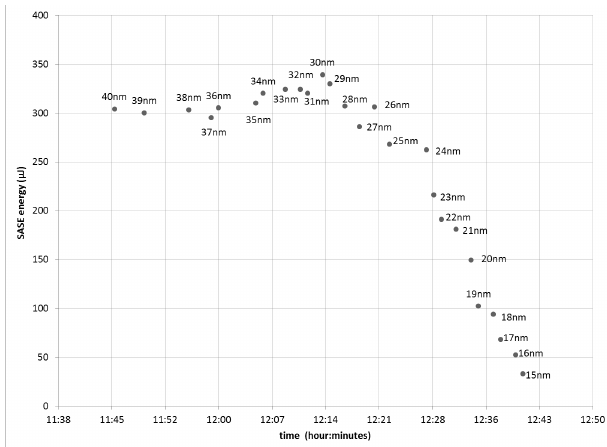
Figure 3. Fast wavelength scan at FLASH2 performed while FLASH1 delivered the beam to users at 13.5 nm (electron beam energy 699 MeV). This scan was performed with standard undulator optics (see